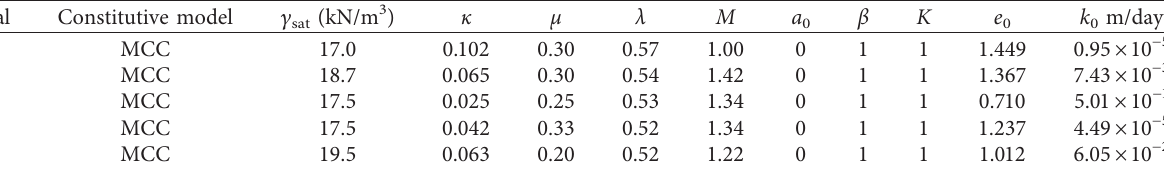
Table 3: Calculation parameters of the soft soil foundation.